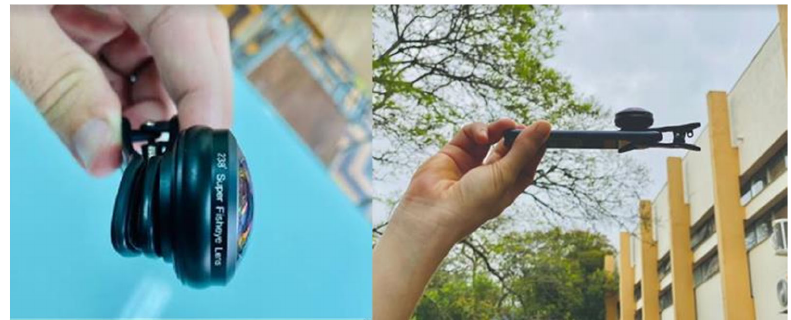
Figure 3. Instruments used to take the SVF photos. (Source: Photographs taken during field work). Authors (2022).